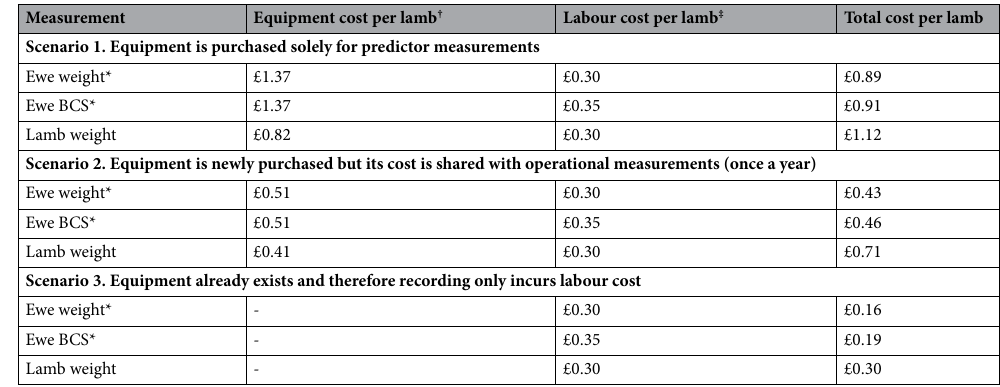
Table 4. Cost scenarios used to estimate net information values. * Corrected for the average litter size (1.88). † Based on the following assumptions about capital costs and life cycles — SRS2 stick reader: £620.17 over 5 years. EziWeigh7i weighing head: £815.08 over 10 years. Border Software weigh crate: £2724 over 10 years. Handling system: £5395 over 30 years. ‡ Based on the following assumptions about labour requirements and wage rate — Weighing: 0.9 min per animal. BCS: 1.05 min per animal. Wage rate: £20 per hour or 0.33p per minute (covering two workers).